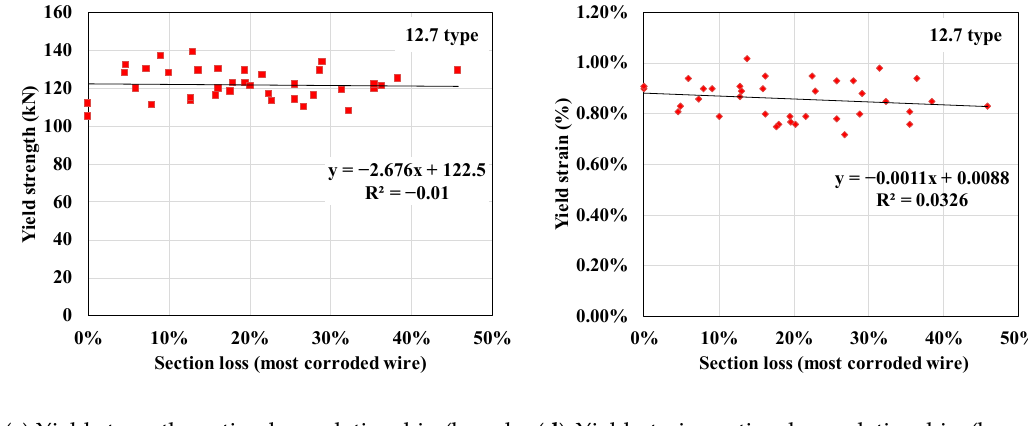
( c ) Yield strength - section loss relationship (based on the most corroded wire). Figure 13. Yield properties of corroded strands, evaluated via the section loss of the most corroded wire in each strand.